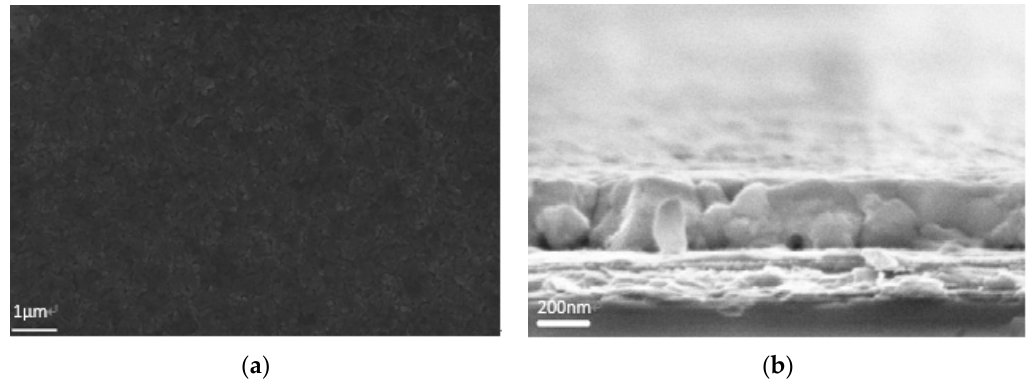
Figure 3. Smooth, uniform, pin ‐ hole free perovskite film ( a ) top ‐ view; ( b ) cross ‐ section SEM images.